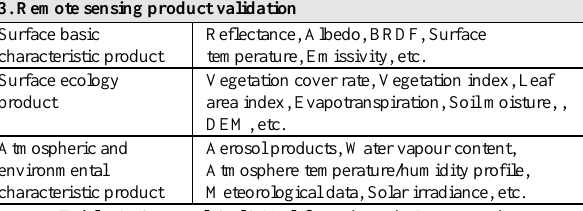
Table 1. General Cal&Val functions in Baotou site